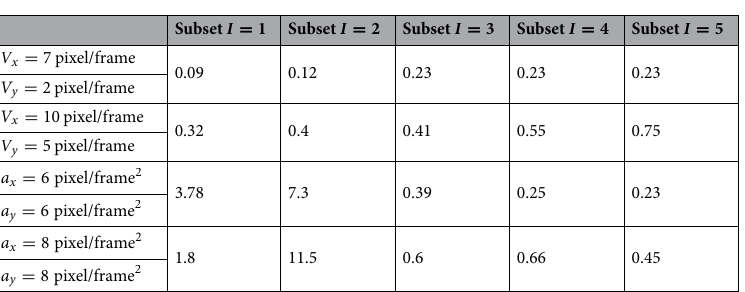
Table 3. Average error in pixel estimation for different velocities and different number of subsets I